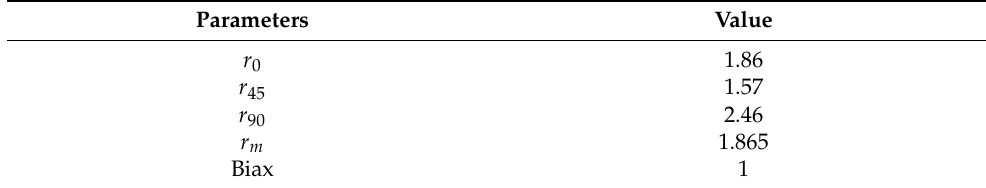
Table 2. Value of parameters of Hill48 model adopted for yield surface.